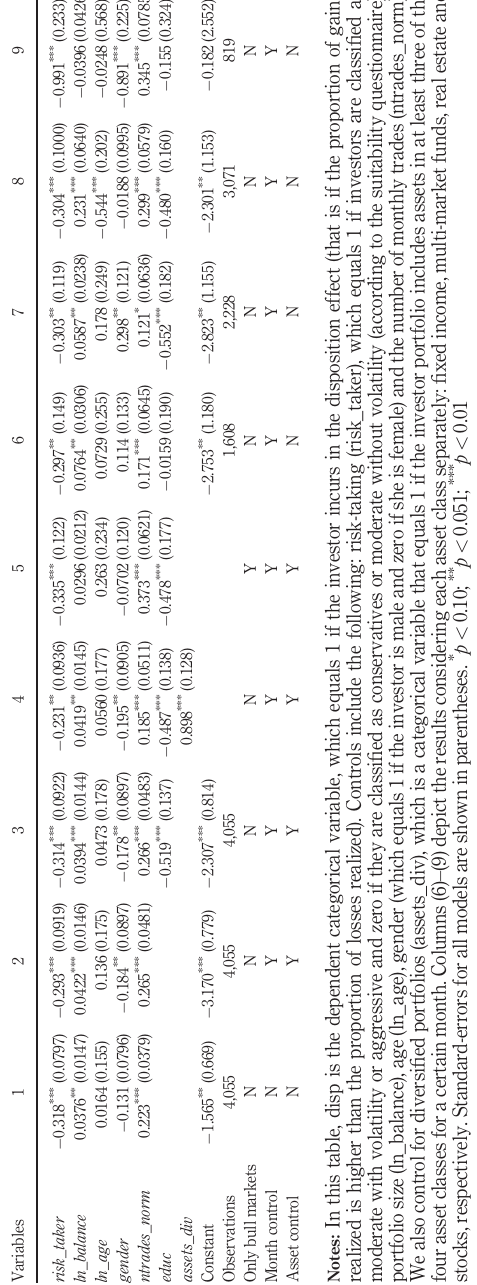
Table 3. Logistic